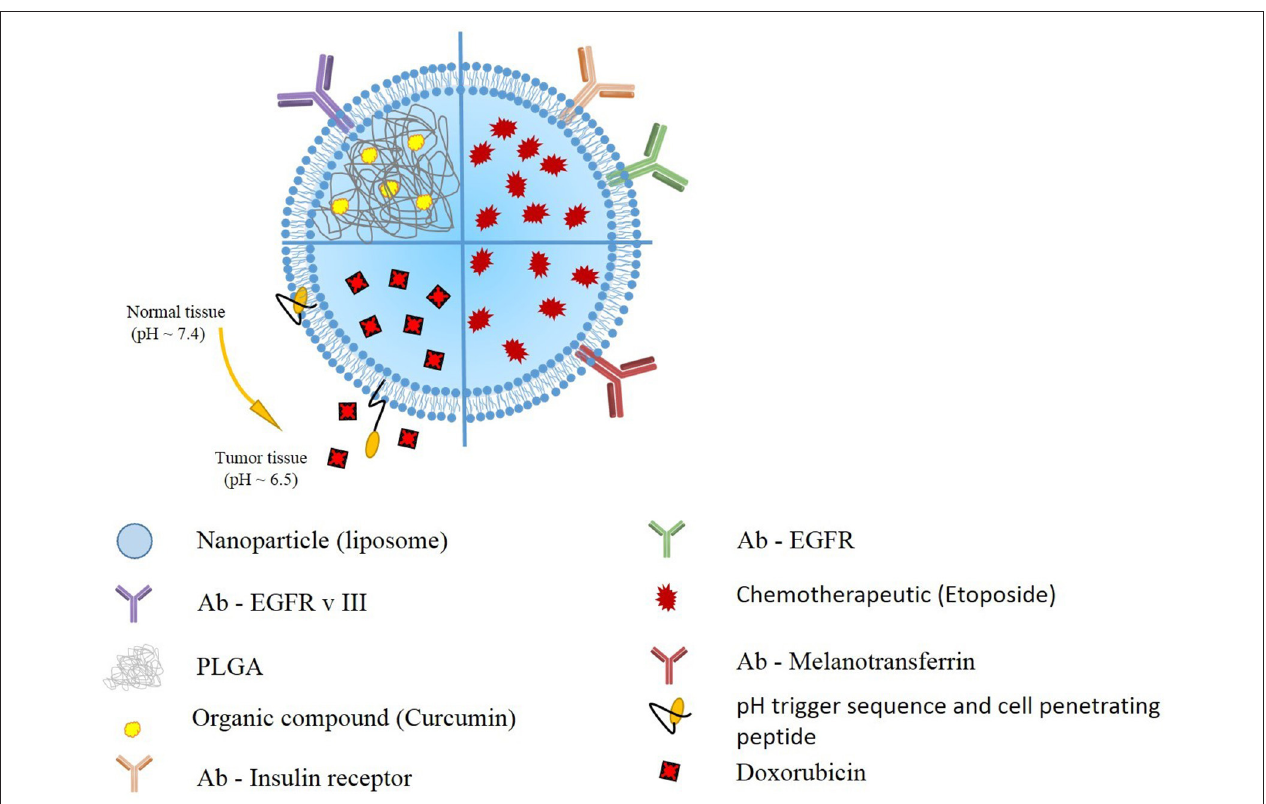
FIGURE 2 | Schematic presentation of selected liposomal nanoparticles. Liposomal nanoparticles are versatile, and can be loaded with wide variety of anti-oncogenic compounds, such as curcumin, etoposide, and doxorubicin). To further enhance the targeting, the outer layer includes antibodies targeting GBM cells, or pH responsive and cell penetrating